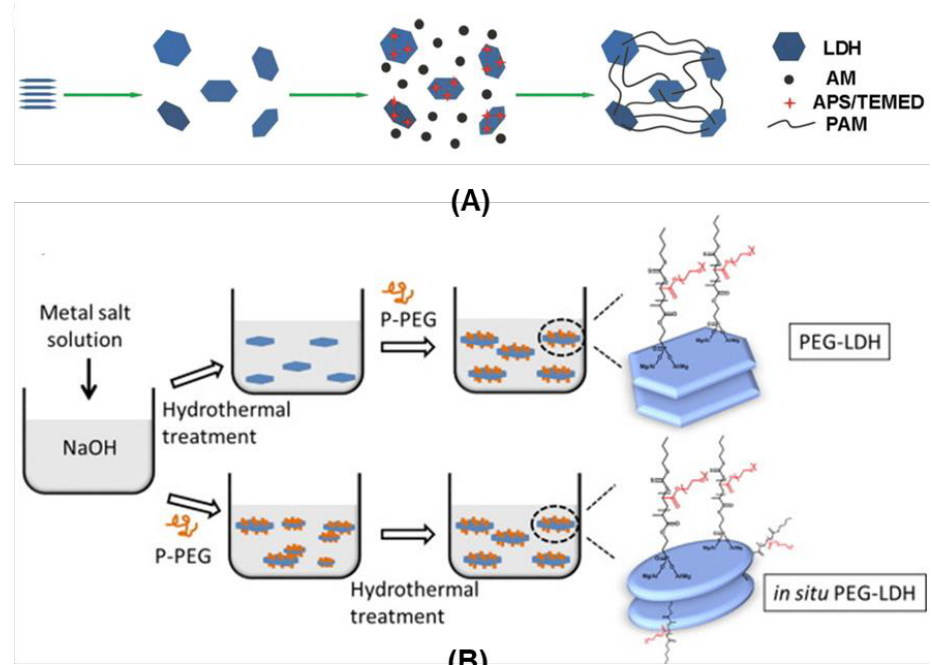
Figure 9. Schematic representation of methods used for ( A ) preparation of PAM/Mg R Al-LDH hydrogel by in situ polymerization; AM: acrylamide; APS: ammonium peroxydisulfate; TEMED: N,N,N′,N′ -tetramethyl-ethylenediamine (reprinted from Wu and Chen [120] with permission of Wiley-VCH GmbH) and ( B ) PEGylation of LDH nanolayers (reprinted from Cao et al. [121] with permission of Elsevier Inc.).